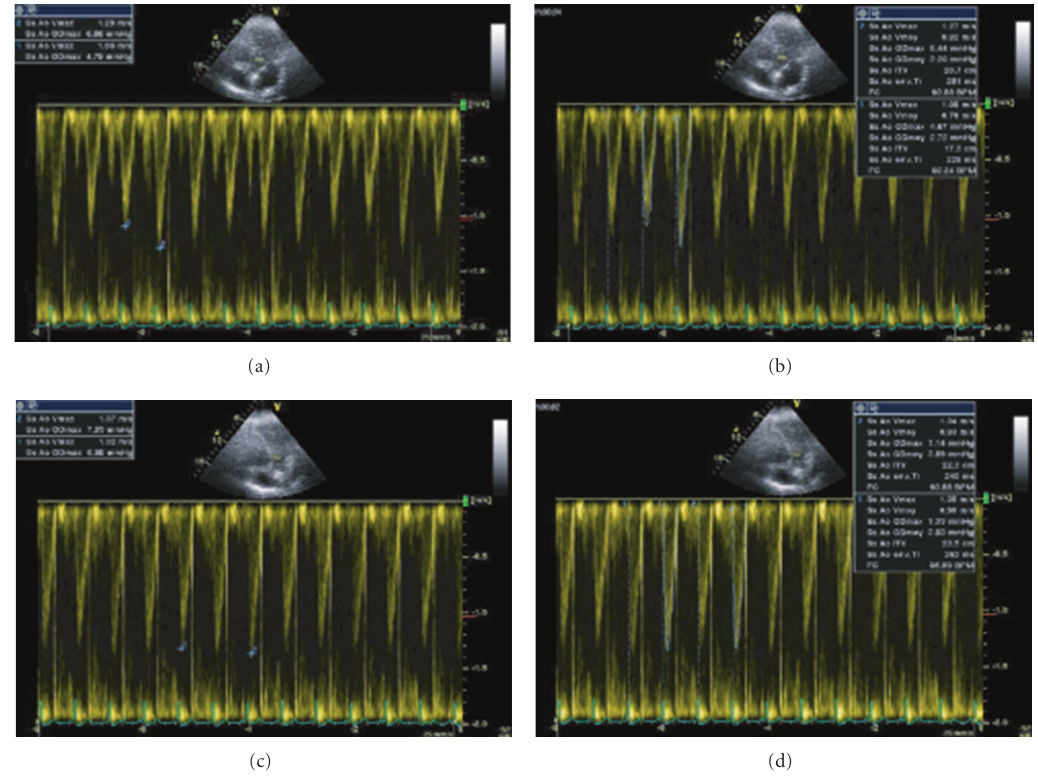
Figure 2: Respiratory variations of maximal velocity (Vmax) (a and c) and VTI (b and d) of aortic blood flow recorded with a pulsed Doppler transthoracic echocardiography in a mechanically ventilated patient (a and c). Presence of significant respiratory variations of Vmax (Vmax − Vmin/[Vmax + Vmin/2]; 1.29 − 1.09/1.19 = 17%) and VTI (VTImax − VTImin/[VTImax + VTI min/2]; 20.7 − 17.3/19 = 18%). (b and d) Same patient after volume expansion, regression of the respiratory variations: Vmax (1.37 − 1.32/1.34 = 4%), VTI (23.5 − 22.3/22.9 = 5%). Reproduced with permission from Levitov et al. “Critical care Ultrasonography” Mc Graw Hill